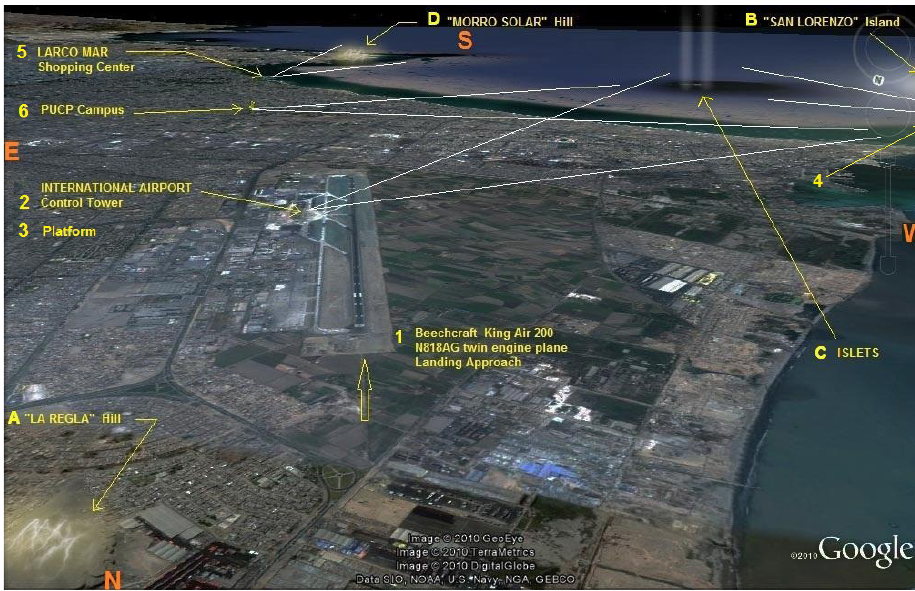
Fig. 7. Partial view of the city of Lima from the air: the whole scenario. Letter locations denote sources of luminescence, number locations denote position of observers and the white lines show the view angle of video cameras and visual observations